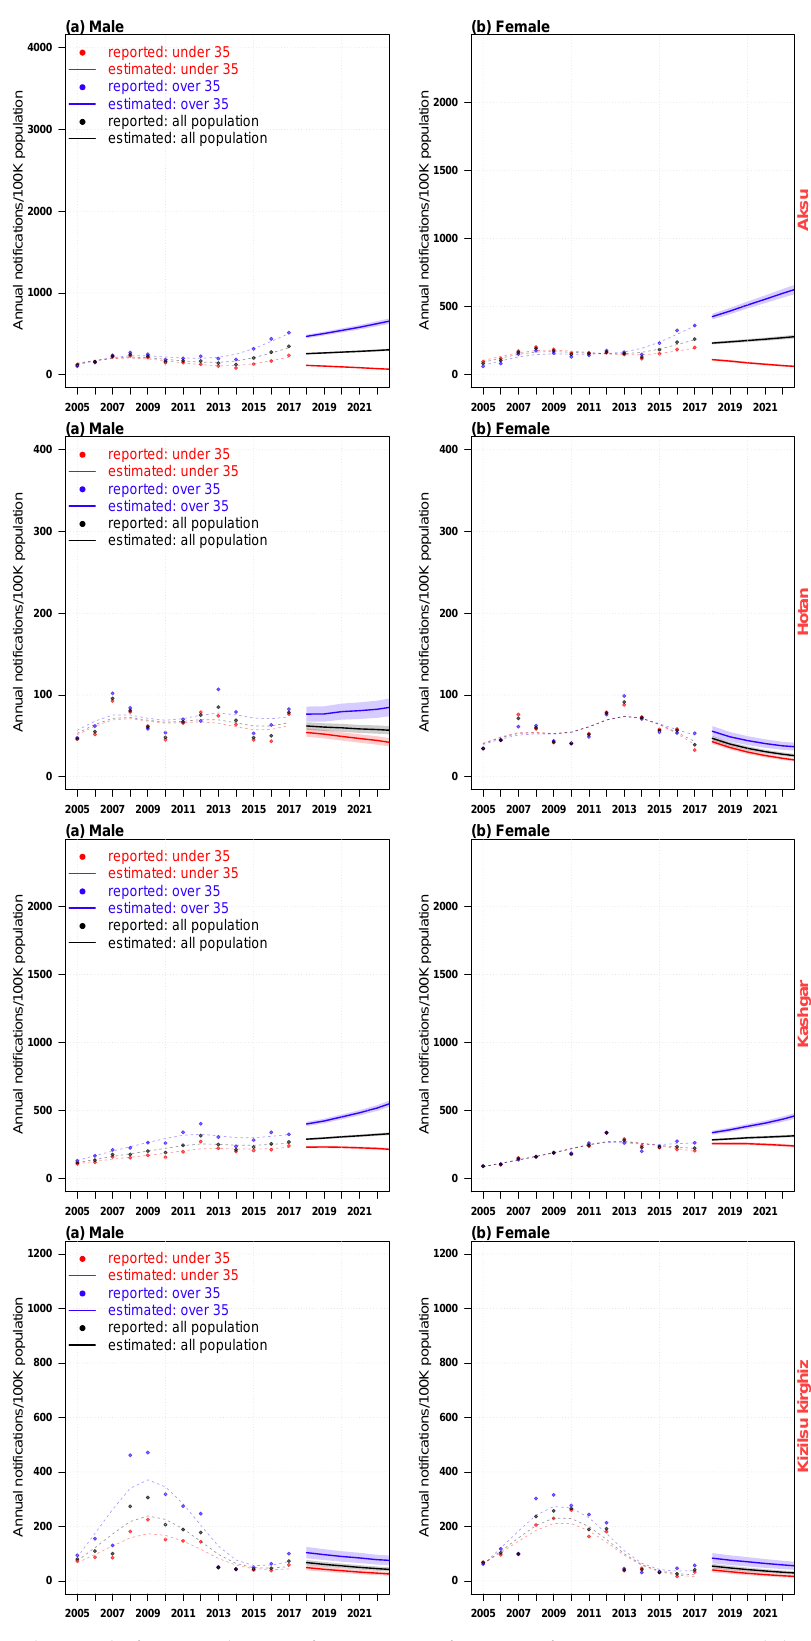
Figure 11. The trend of HB incidence in four regions of Xinjiang from 2005 to 2017, and the prediction of HB incidence trend from 2018 to